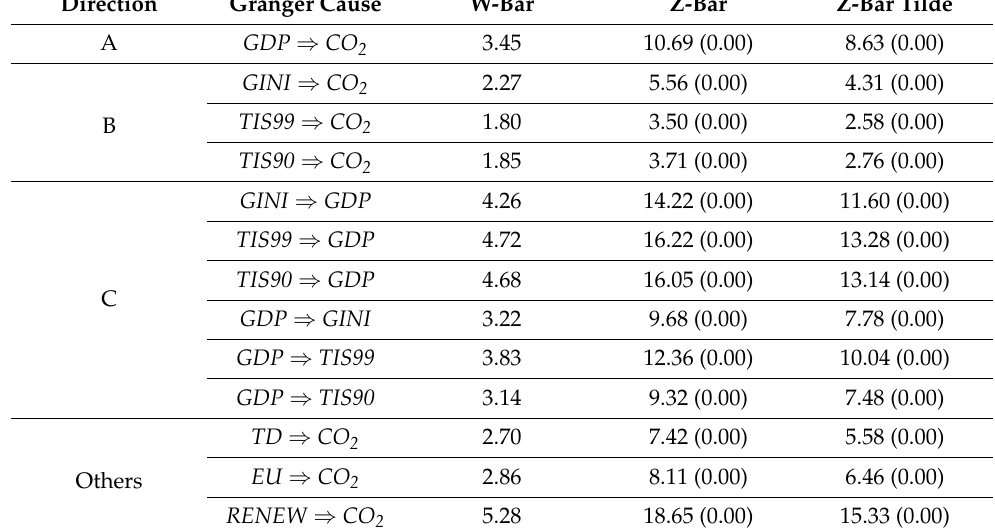
Table 8. Results of granger